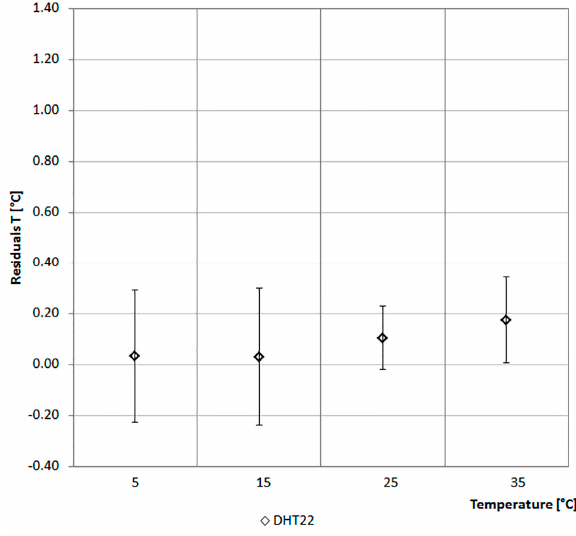
Figure 11. Air temperature DHT22 data after approximately two years.